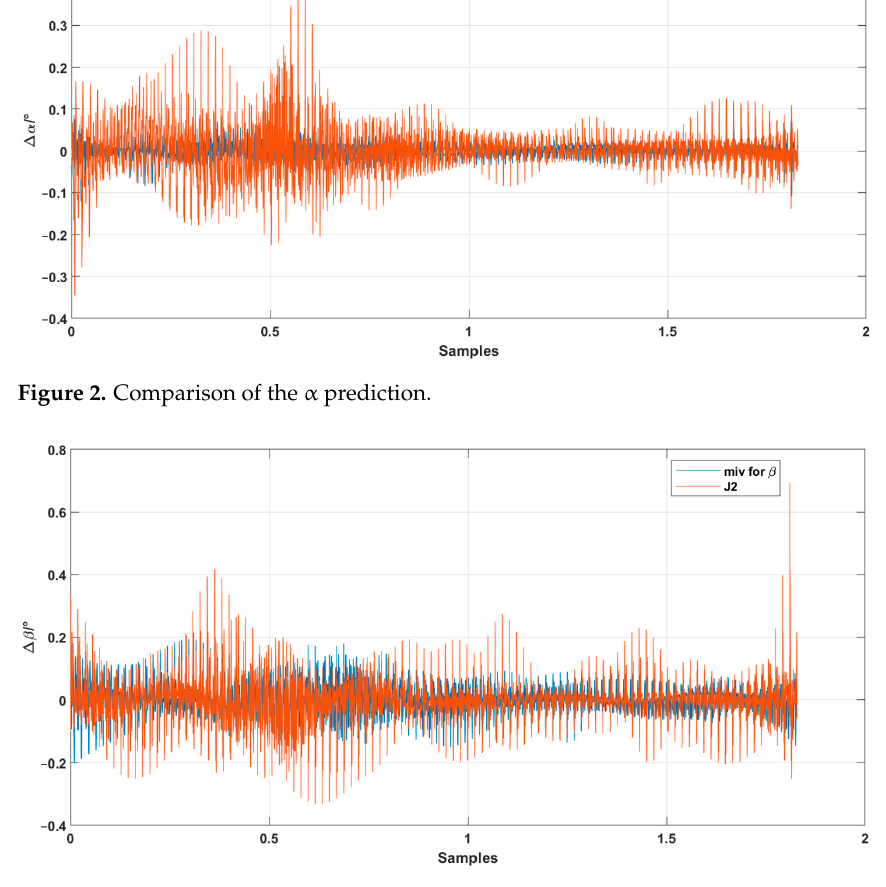
Figure 3. Comparison of the β prediction.